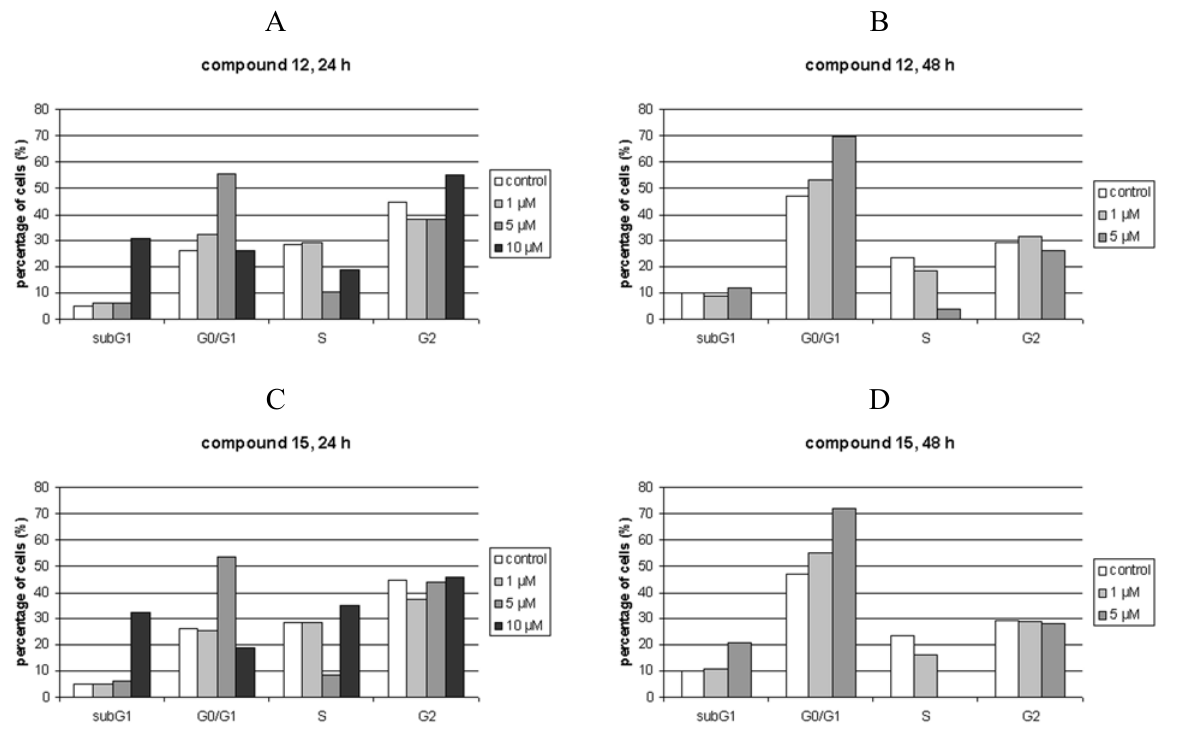
Figure 2. Cell cycle analysis of HCT 116 cells treated with 1, 5 and 10 μ M compounds 12 and 15 , 24 h (A and C, respectively), or 48 h (B and D, respectively). The histograms show percentages of live cells in G0/G1, S or G2/M phase, along with the number of dead (subG1) cells, where subG1 population is expressed as a percentage of total number of measured